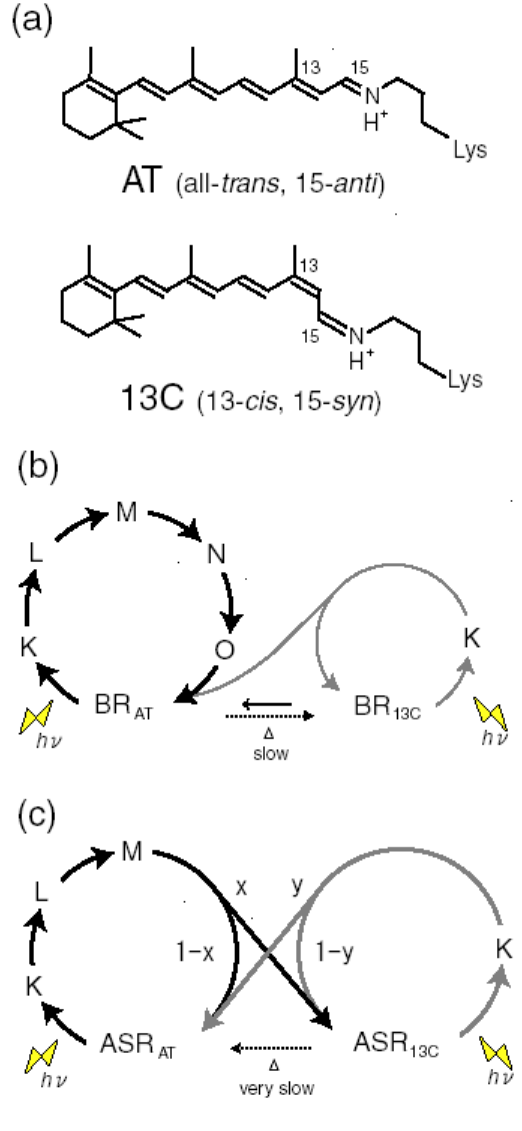
Figure 22. (a). The structure of the retinal chromophore of microbial rhodopsins in the dark. (b). Photo and thermal reaction scheme in a light-driven proton pump bacteriorhodopsin (BR). Only BR possesses proton-pump activity, and the reaction of BR is 100 % cyclic AT AT without any branching reaction into BR . Dotted arrows represent thermal reaction in the 13C dark. (c). Photo and thermal reaction scheme in Anabaena sensory rhodopsin (ASR). While ASR is a predominant species in the dark (dotted arrow), photoexcitation of ASR and AT AT ASR yields the reaction of each species, either cyclic or branching, leading to the 13C photocycle or photochromism, respectively. x and y are the branching ratio from ASR and AT ASR , respectively. These figures are reprinted with permission from Kawanabe et al [71]. 13C Copyright 2007 American Chemical